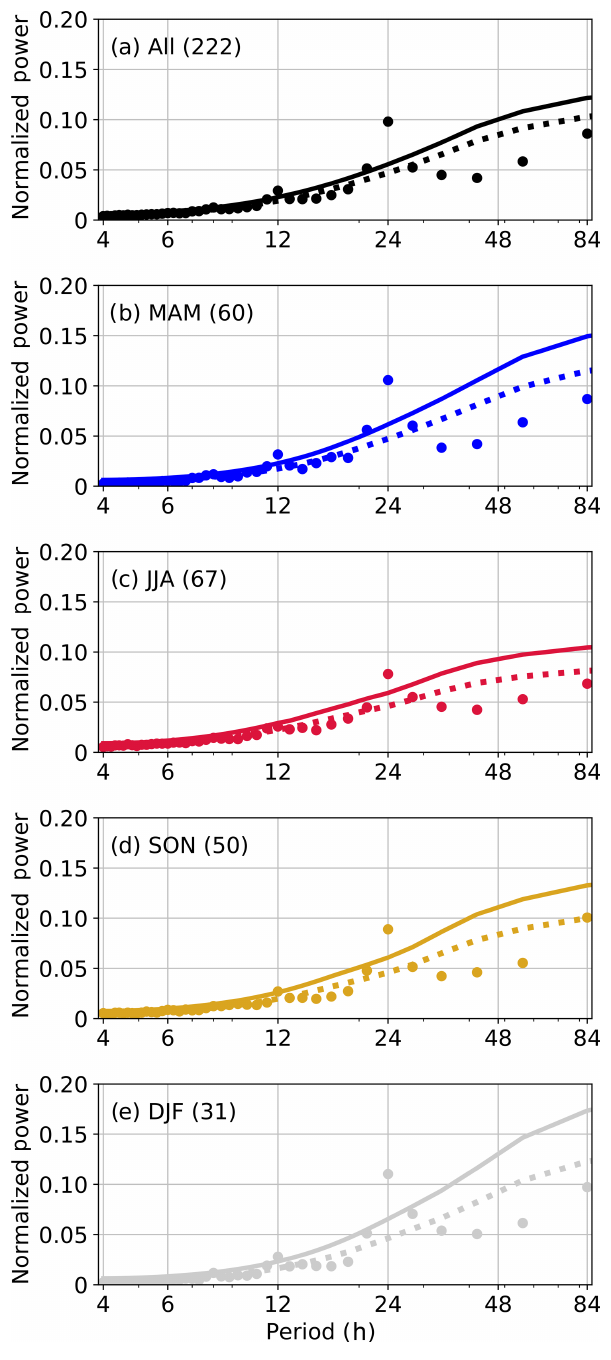
Figure 5. Normalized power spectra for N T for the entire period (a) and by season (b–e) . The dots represent power associated with the data. The dashed lines represent an estimate of the red noise power spectrum for each dataset, and the solid lines represent the 99% significance testing level, as described in the text. The values in the parentheses are the number of weekly data chunks used in this anal-